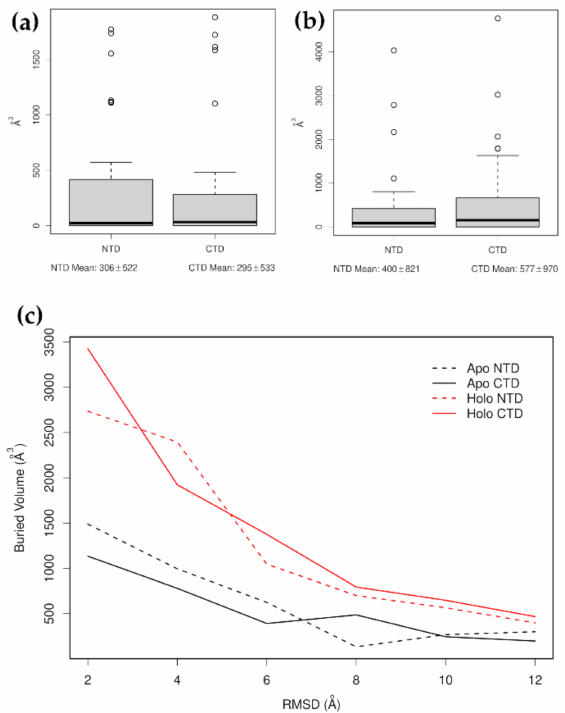
Figure 4. Plots of the buried volumes of lobe I and lobe II produced by structures distorted with a target RMSD of 12 Å, ( a , b ), and progressively with targets of 2, 4, 6, 8, 10, and 12 Å ( c ). It can be seen that in the Apo form, lobe I maintained a greater buried volume than lobe II. while the reverse was the case in the Holo